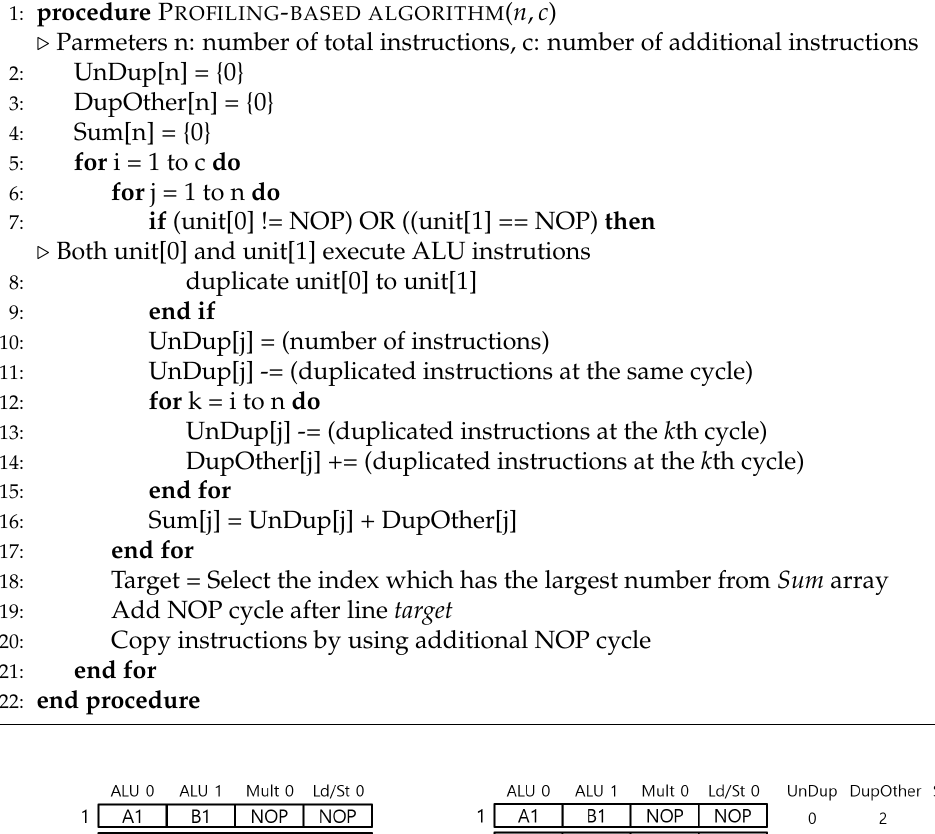
Algorithm 1 Profiling-based algorithm to predict the number of duplicable instructions